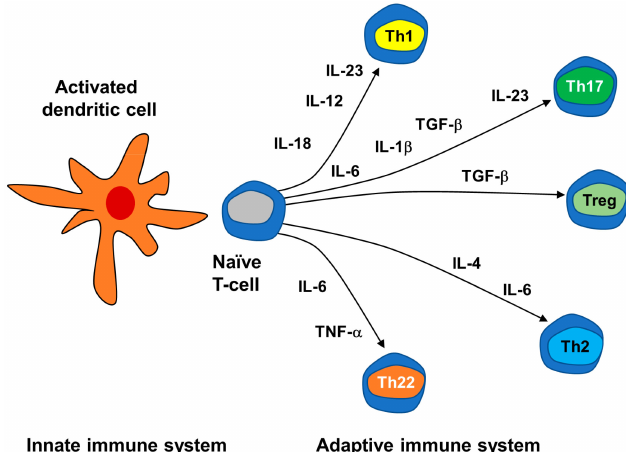
Figure 2. Di ff erentiation of naïve T cells induced by cytokines produced by dendritic cells of the innate immune